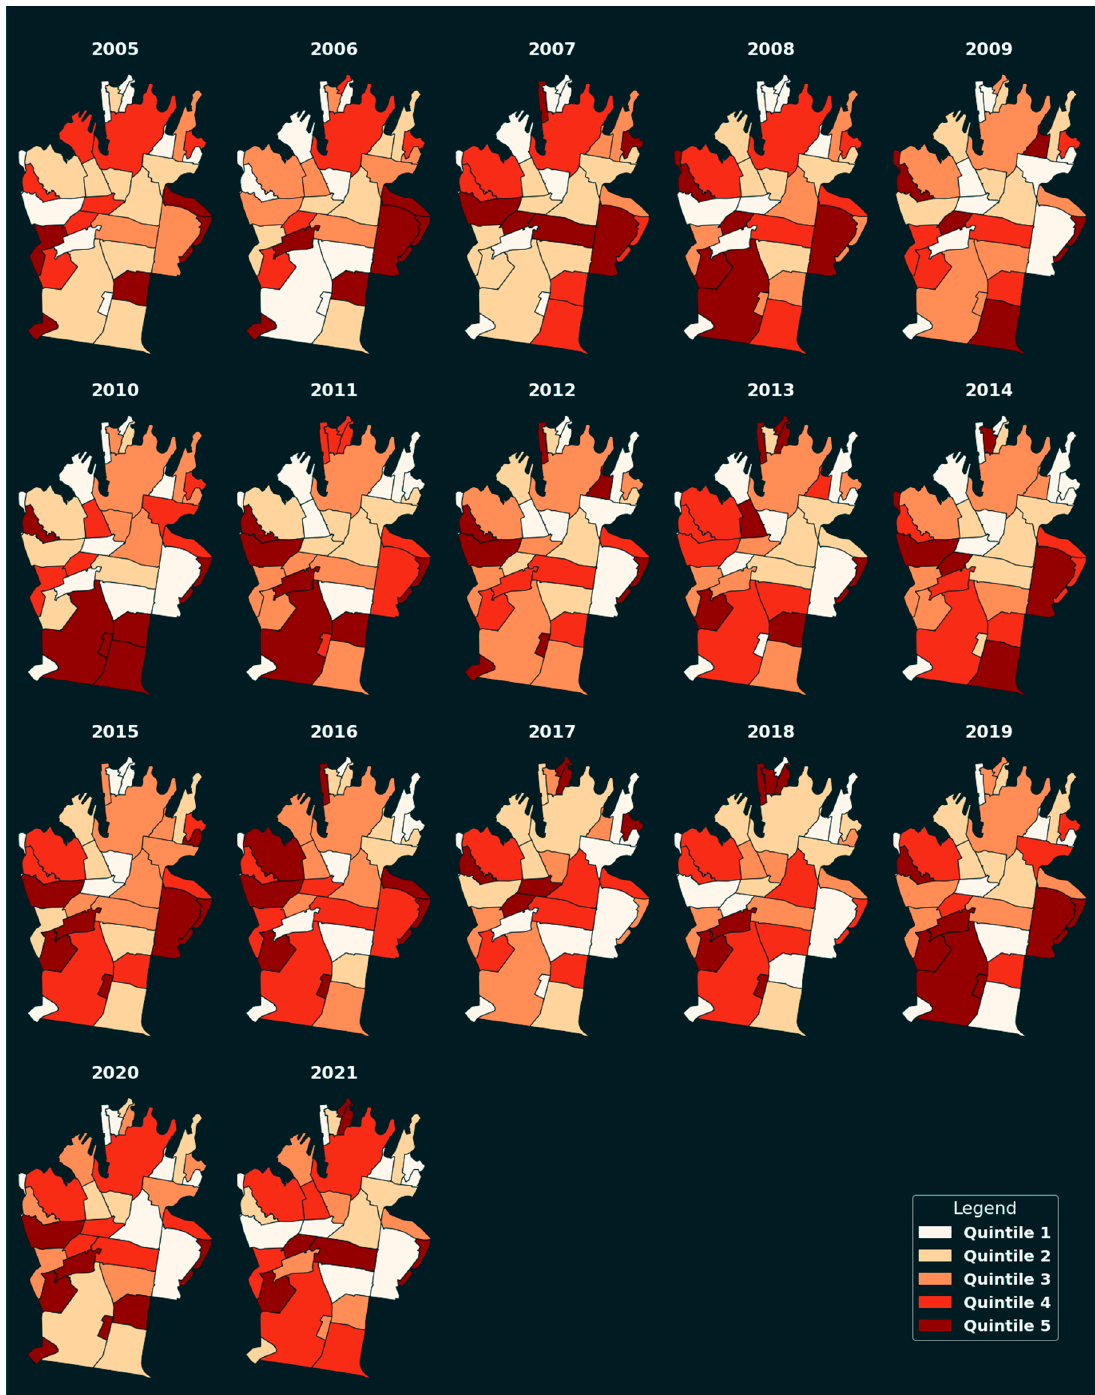
Figure 30. Quintile distribution of median DA estimated cost by suburb by year